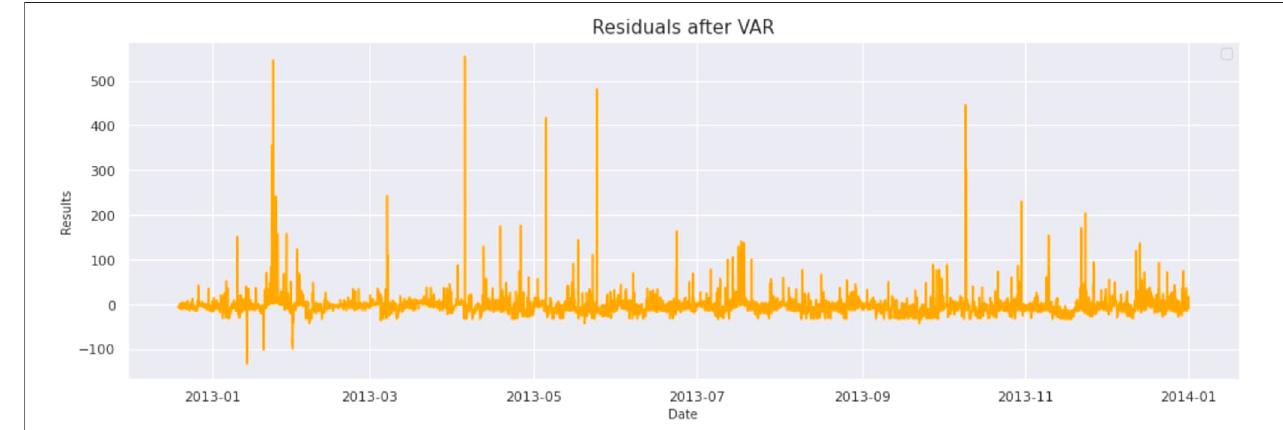
FIGURE 9 | Residuals left after applying VAR (Ontario Demand Data).